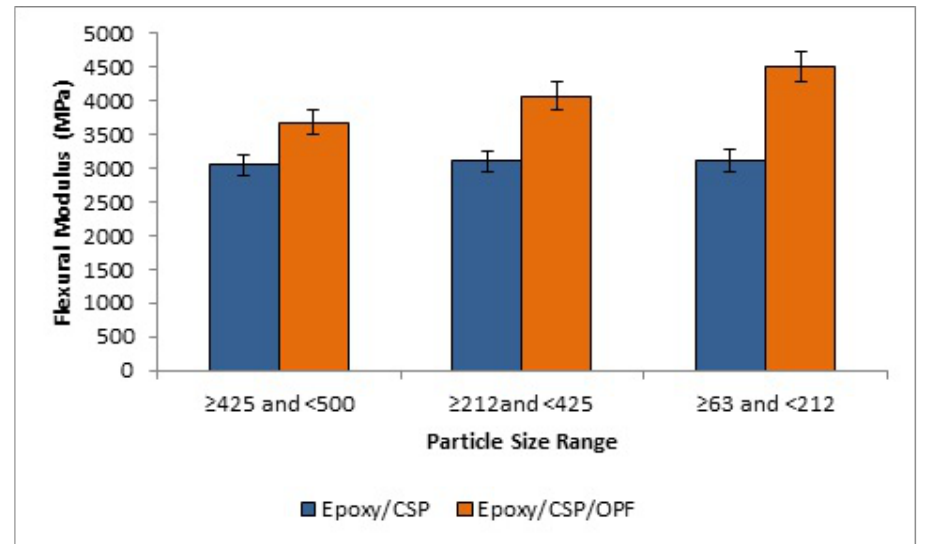
Figure 9: Flexural modulus of epoxy